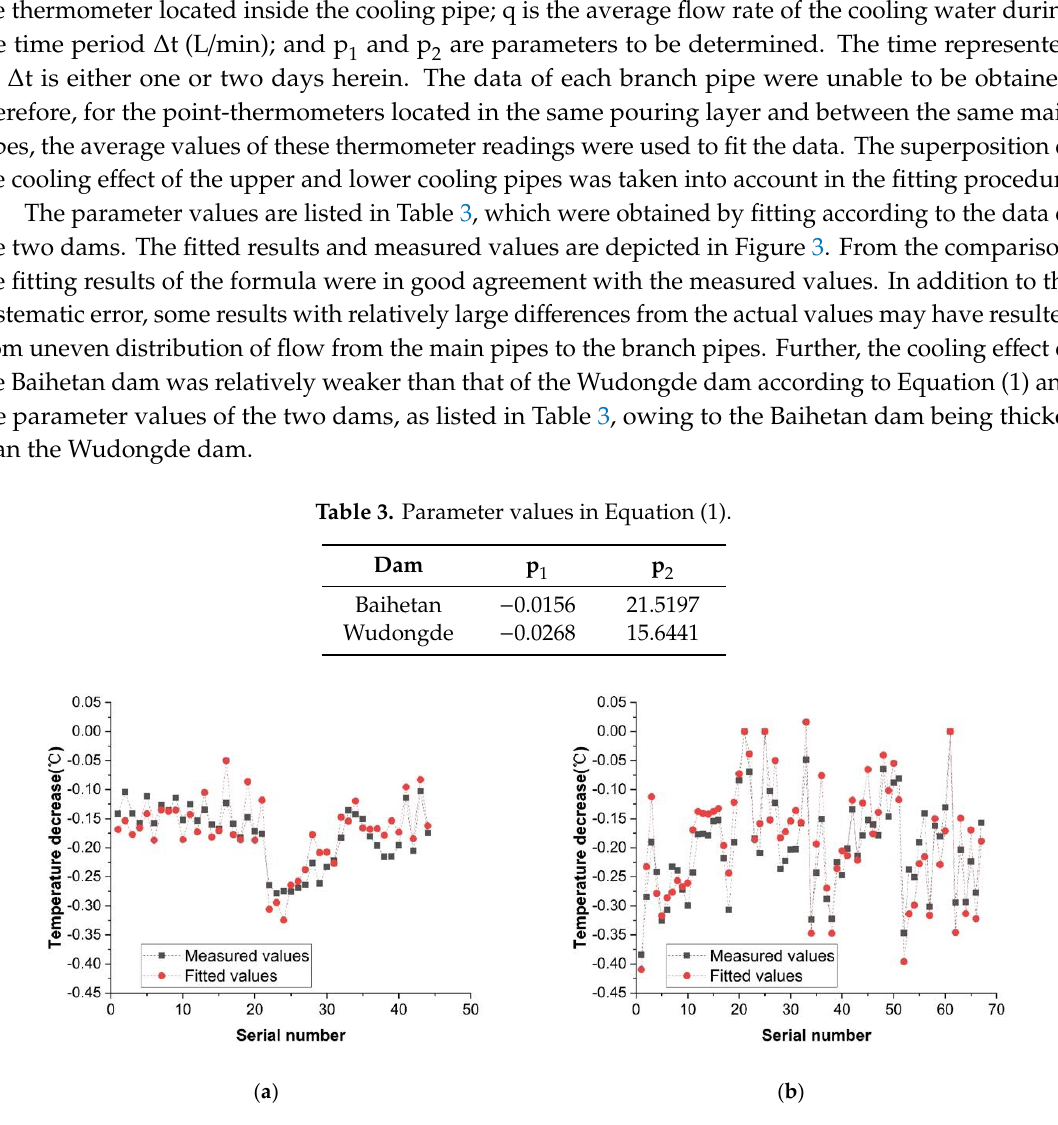
Figure 3. Comparisons of the measured and fitted values of the temperature decrease for the two dams: ( a ) Baihetan dam and ( b ) Wudongde dam.